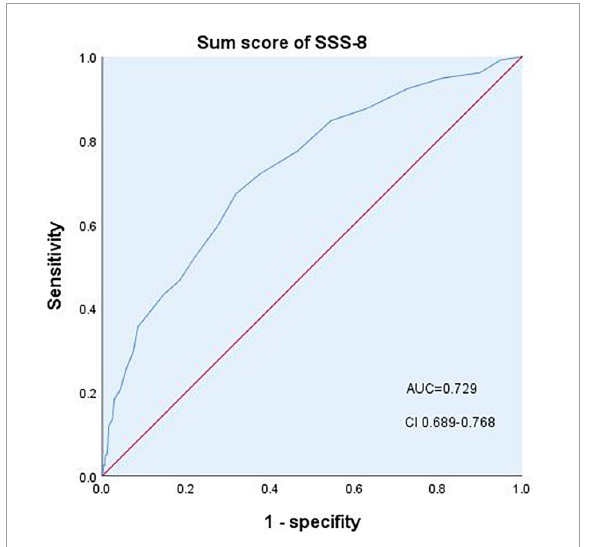
FIGURE2 Diagnostic performance of the SSS-8 sum score. AUC, area under the curve; CI, confidence interval.